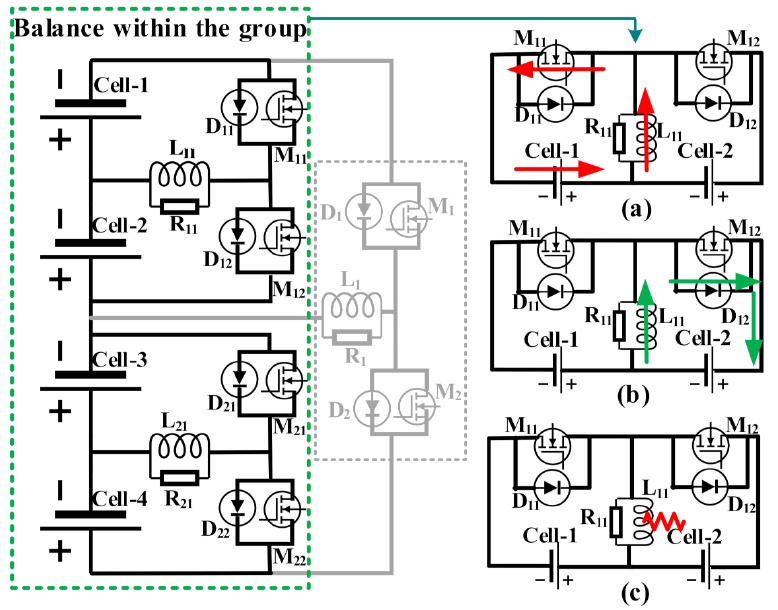
Figure 3. Schematic diagram of intra-group equalization process. ( a ) Cell-1 discharging, ( b ) Cell-2 charging, ( c ) L 11